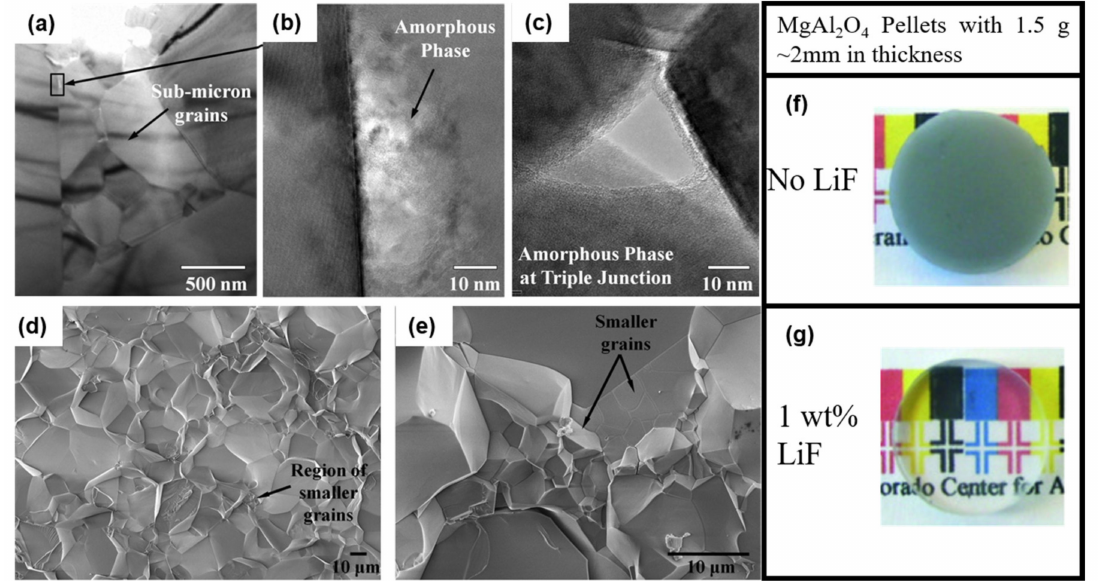
Figure 43. Microstructure of MgAl 2 O 4 spinel by low-purity powder hot-pressed at 1200 ◦ C without LiF ( a – c , f ) and with 1 wt% LiF ( d , e , g ). ( a ) TEM image of sub-micrometer grains; ( b ) TEM image of amorphous phase at interface between matrix grains and sub-micrometer grains; ( c ) TEM image of amorphous phase at triple junctions; ( d ) SEM image of matrix grains ( e ) SEM image of micrometer grains; (f) digital image of a MgAl 2 O 4 pellet without LiF; ( g ) digital image of a MgAl 2 O 4 pellet with 1 wt% LiF [299]. Figure 43 reprinted from International Journal of the American Ceramic Society, 10, Marc Rubat du Merac and Ivar E. Reimanis, Effect of Impurities and LiF Additive in Hot-Pressed Transparent Magnesium Aluminate Spinel, E33–E48, Copyright (2012), with permission from John Wiley and